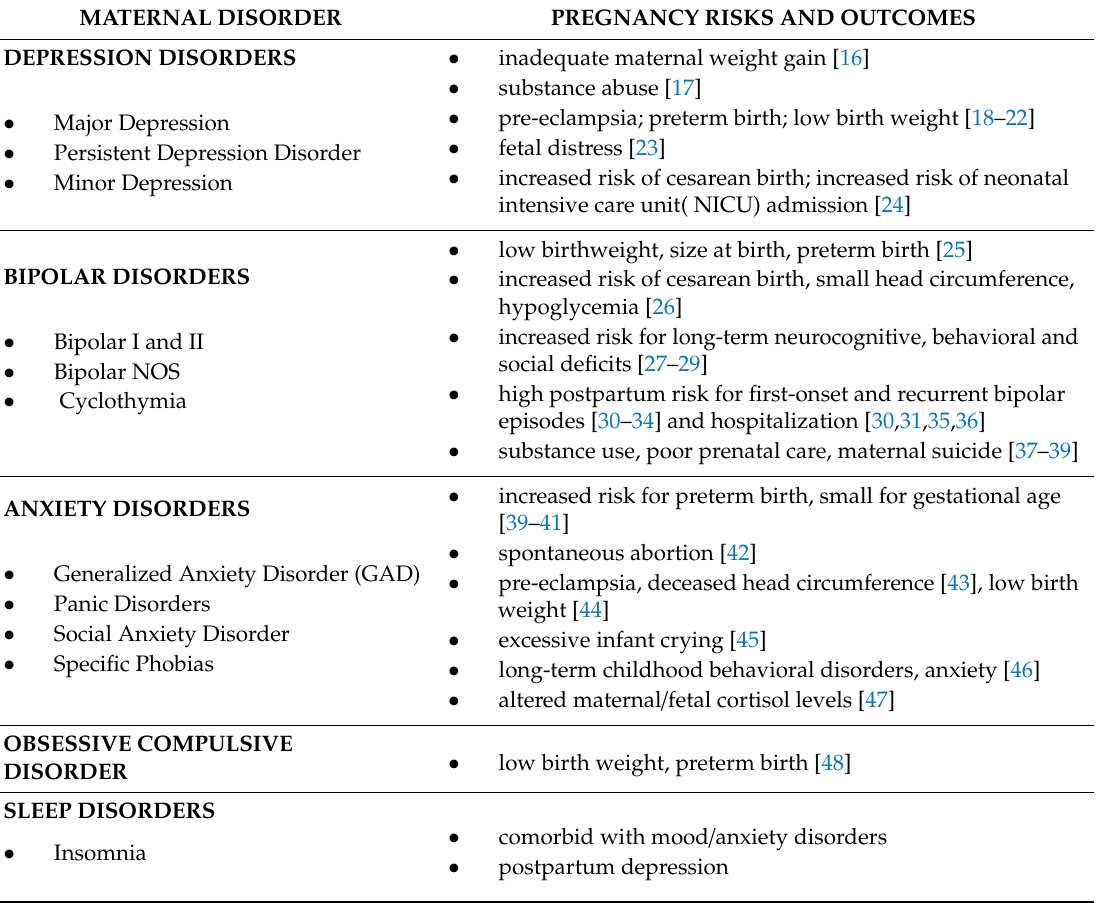
Table 1. Pregnancy risks and outcomes associated with untreated maternal